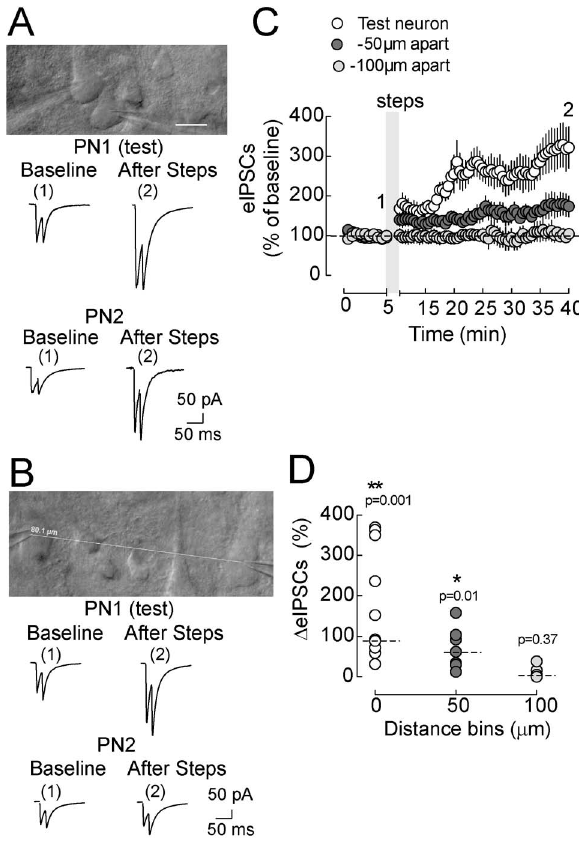
Figure 7. LTPi diffuses to neighboring synapses. (A, Top) Infrared Differential Interference Contrast (IR-DIC) microphotograph of acute cortical slice showing two adjacent recorded layer 5 P neurons ( , 50 m m). (A, Middle) Representative eIPSC traces of one test (PN1) and one adjacent P neuron (PN2) in control and after injecting depolarizing voltage steps in PN1. IPSCs were evoked in the two neurons by a single stimulating electrode placed nearby their perisomatic region. Note that LTPi was observed also in PN2, despite only PN1 being depolarized. (B) Same experiment of (A) but on a different pair of P neurons recorded at a farther distance ( , 80 m m). Note the absence of spread of LTPi in the second, nondepolarized neuron. Scale bar (A and B), 20 m m. (C) Population data of IPSC time course in tested cells (open circles), cells patched up to 50 m m (solid dark gray circles), and at a distance higher than 50 m m from the test neuron (solid light gray circles). (D) D eIPSCs of same data of (D). Data are single values and/or mean and median 6 SEM. * p , 0.05; ** p , 0.001. Numbers 1 and 2 refer to times of trace illustration.